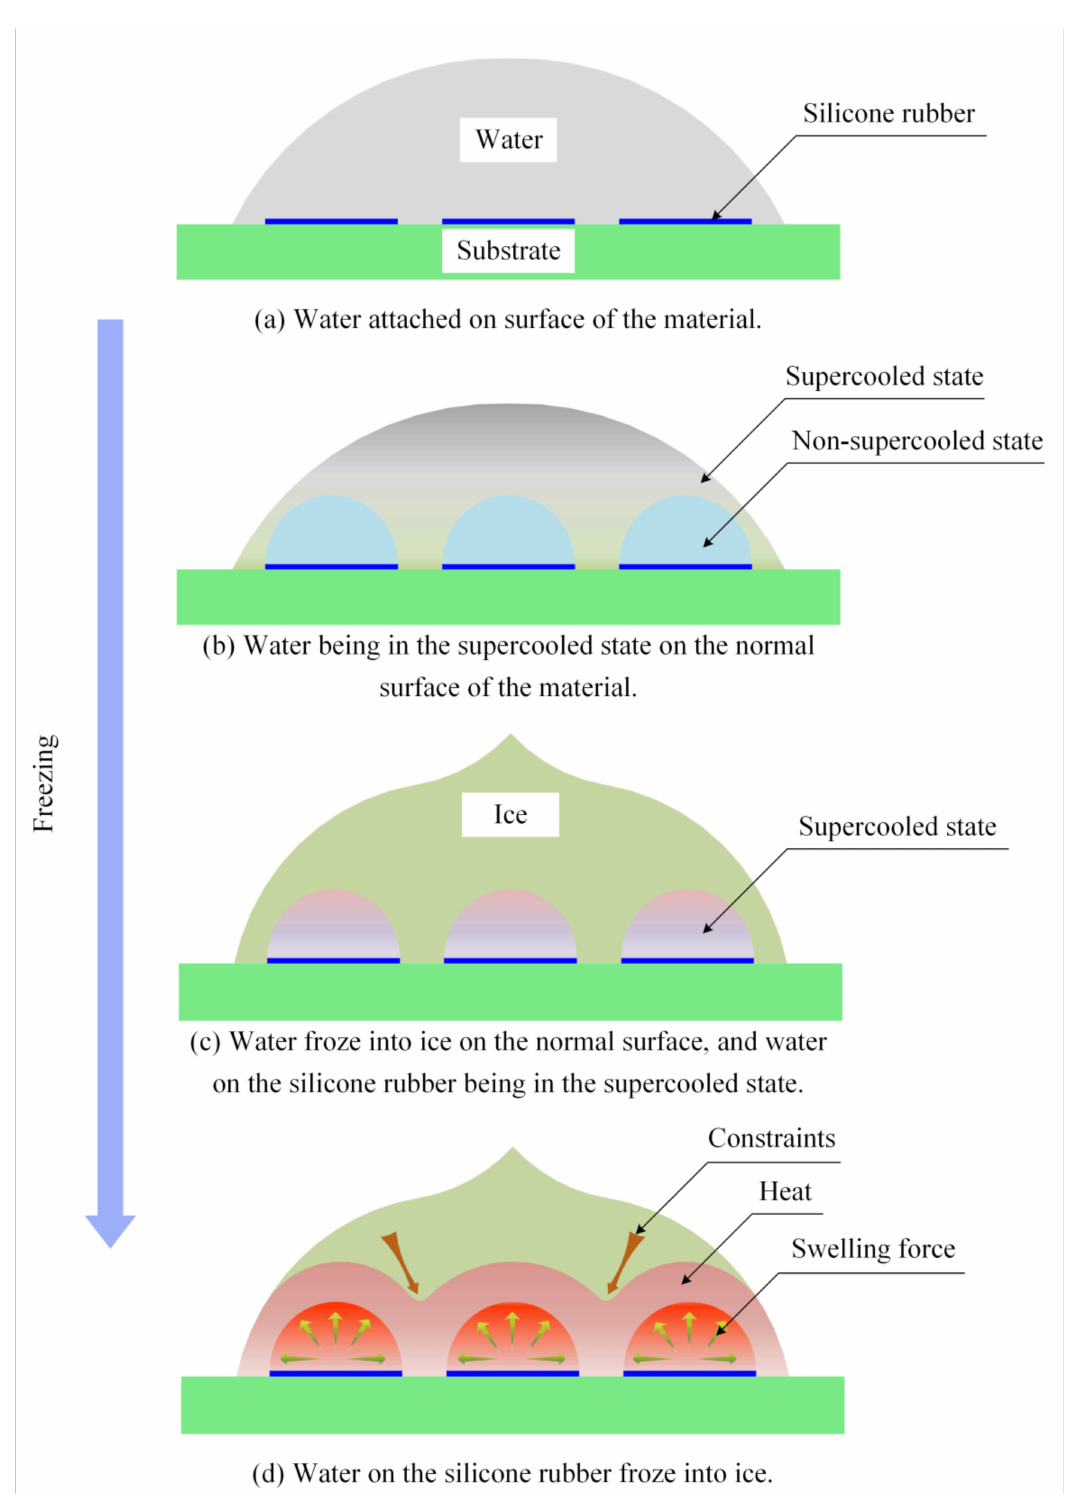
Figure 10. Schematic of the effects of discontinuous thermal conduction on ice adhesion strength. Meanwhile, the adhesion strength of silicone rubber on the substrate surface after 20 freeze–thaw cycles was tested dependent on the [48]. The experimental conditions were the same as those of the ice adhesion strength test. The area of silicone rubber falling off in the central grid area of silicone rubber was calculated by Photoshop 2020. Compared with standard a, it was determined that the adhesion grade of silicone rubber on the substrate surface was 4B after 20 freeze–thaw cycles. As shown by the test results, the